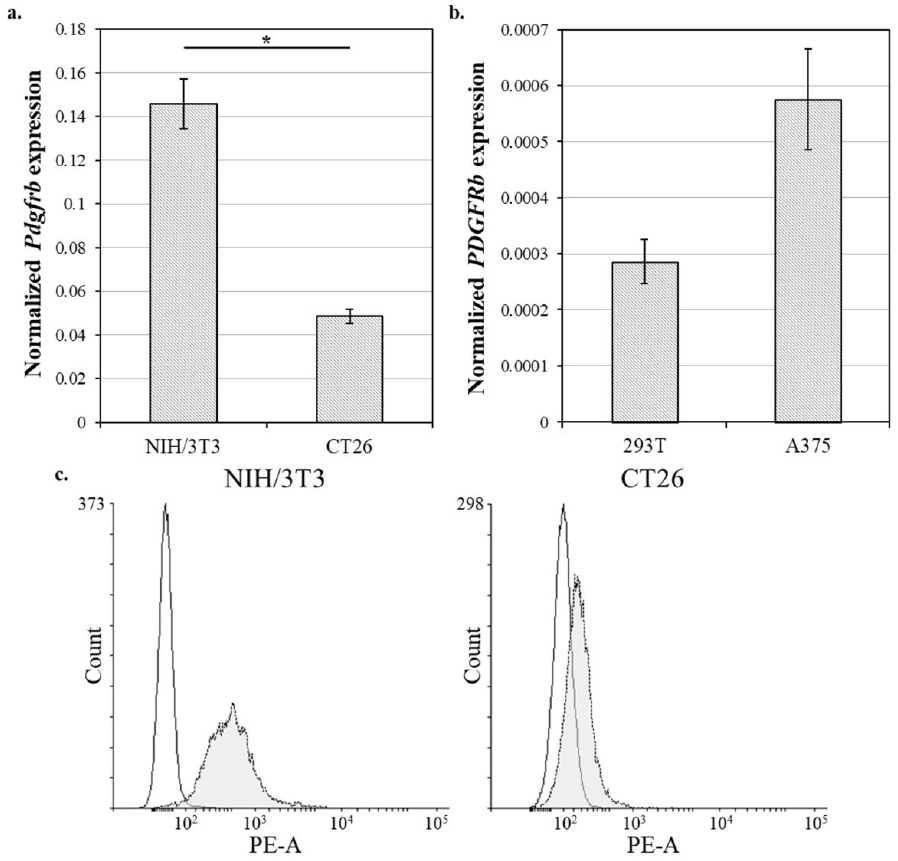
Figure 3. PDGFRB (β-type platelet-derived growth factor receptor) expression profiling of different cell lines. ( a )—Relative mRNA level of Pdgfrb in murine cell lines, ( b )—Relative mRNA level of PDGFRB in human cell lines. Mean values (n = 3) are shown, error bars represent standard error (n = 3); * p < 0.05. ( c )—Flow cytometric analysis of NIH/3T3 and CT26 cell lines, cells without staining (open histogram) and stained with anti-mouse CD140b-(PDGFRB)-PE antibodies (filled histogram) are shown.